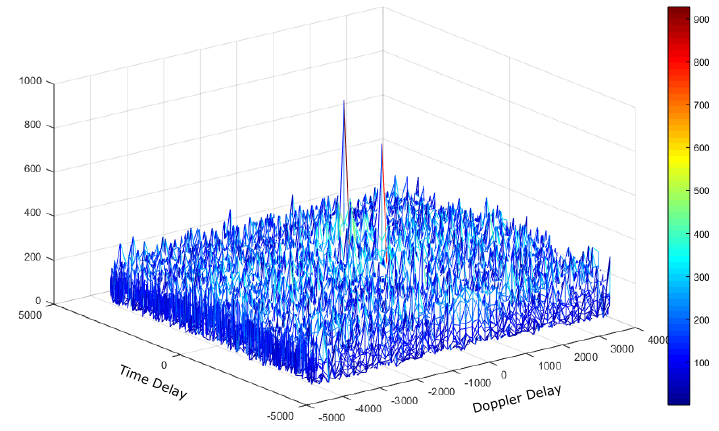
Figure 22. Two closer scatterers using chirp pulses (MMPP), at − 5 dB